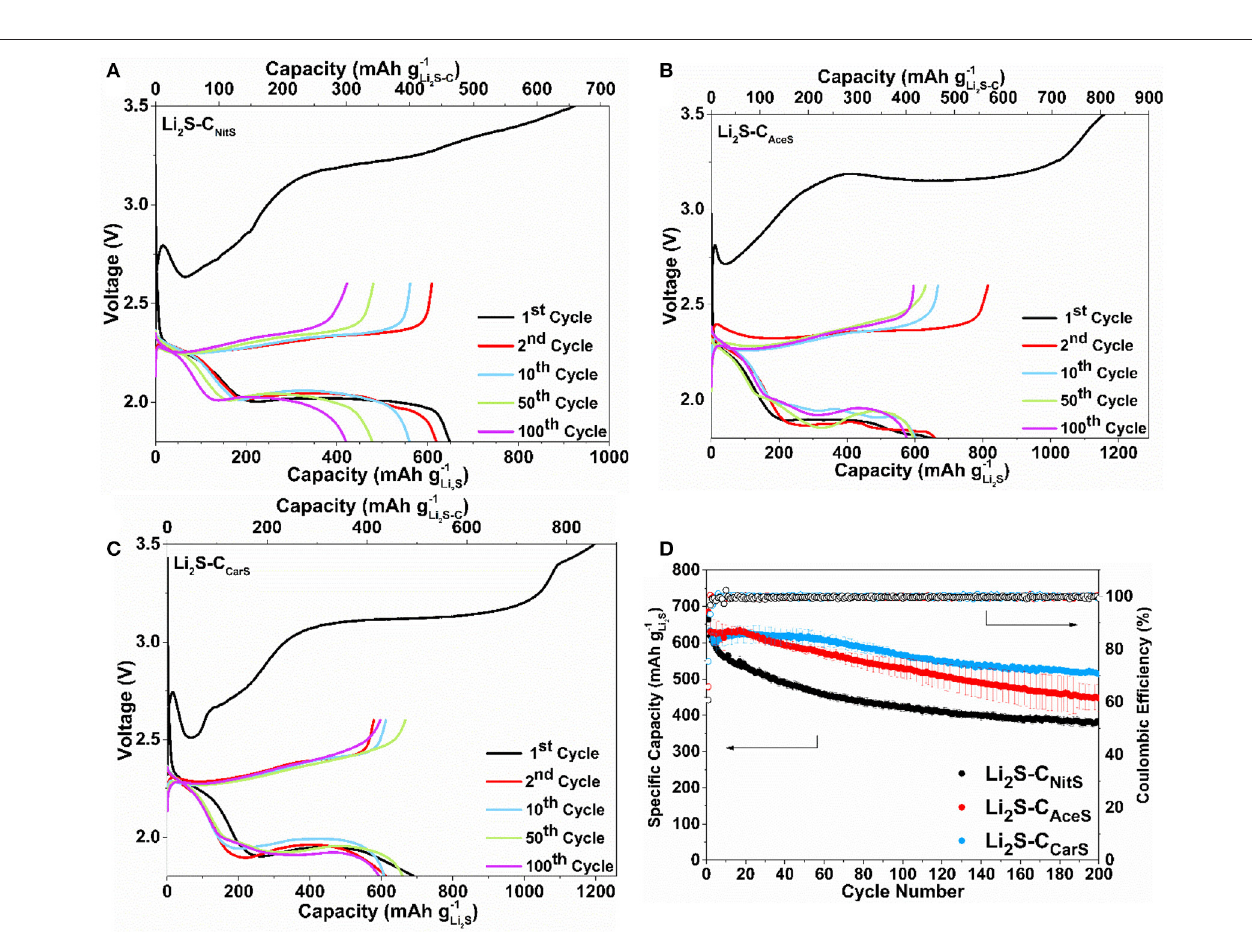
FIGURE 5 | Representative charge-discharge curves of (A) Li 2 S-C NitS , (B) Li 2 S-C AceS , (C) Li 2 S-C CarS at the 1st, 2nd, 10th, 50th, and 100th cycle, and (D) the cycle stability of these composites at 117mA g − 1 .